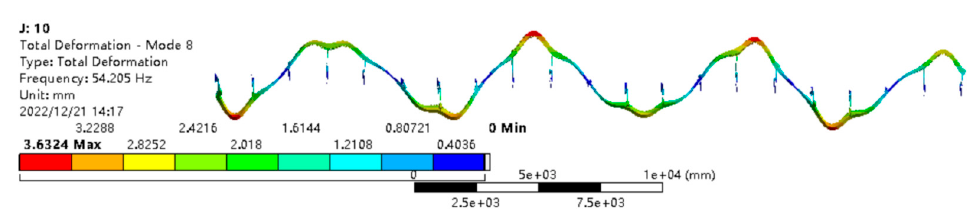
Figure 5. Results of the first eight modal analysis of 10 tracks.